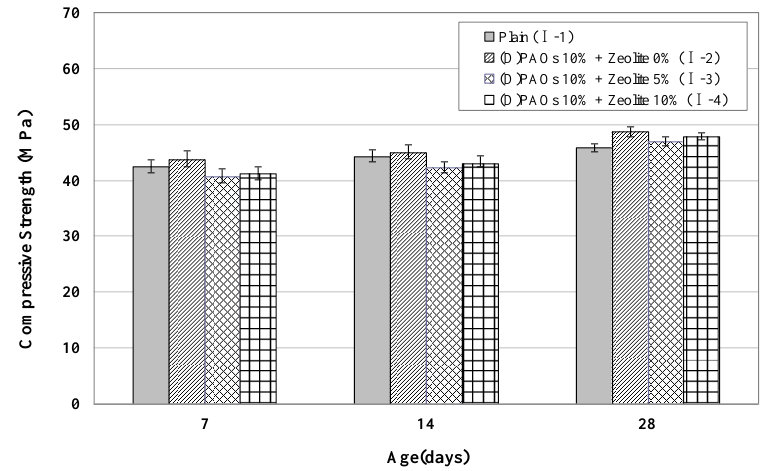
Figure 6. Compressive strength of mortars produced with (D)PAOs and zeolite.